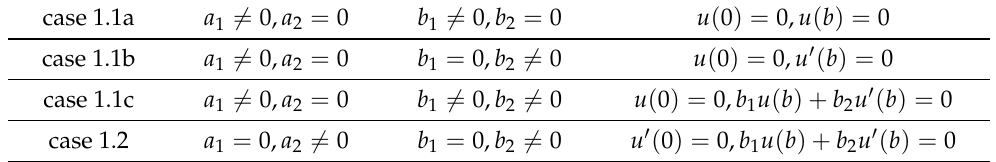
Table 4. Examples of Sturm–Liouville problems with a = 0, b > 0, x ∈ ( 0, b ) , case 1: a 1 · a 2 = 0.